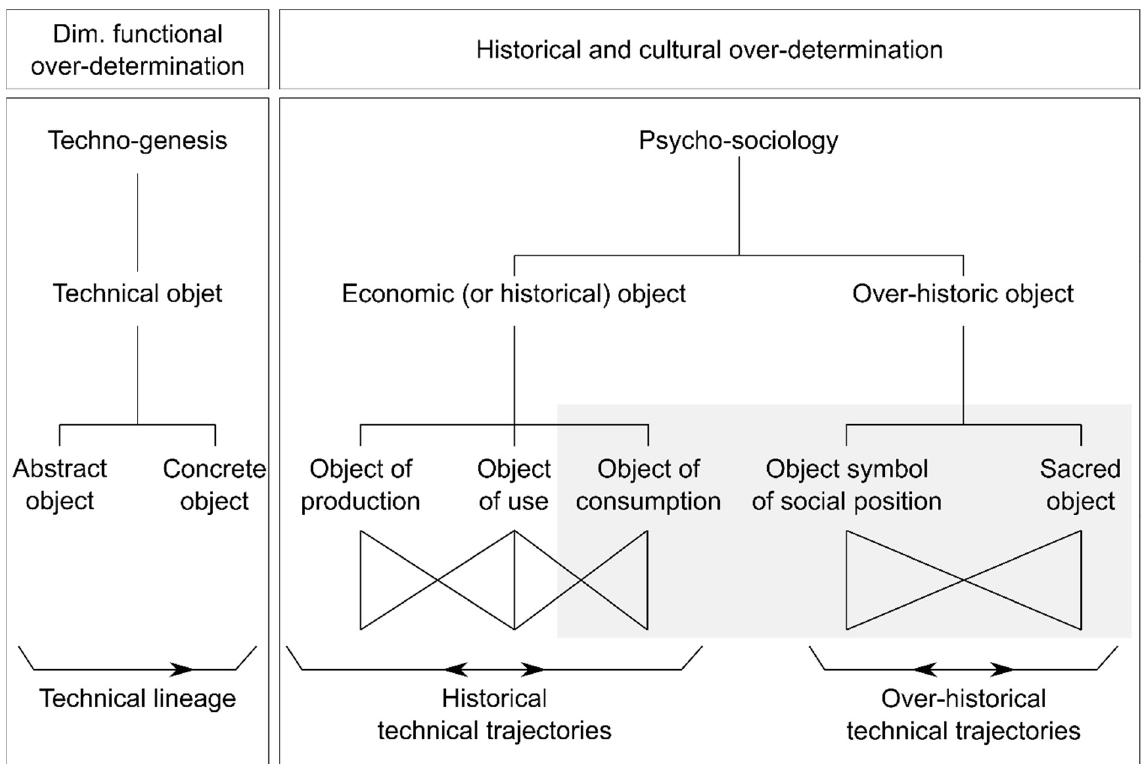
Figure 6. Two complementary perspectives of prehistoric objects. The grey box represents the possible overlap between the historic object and the over-historic